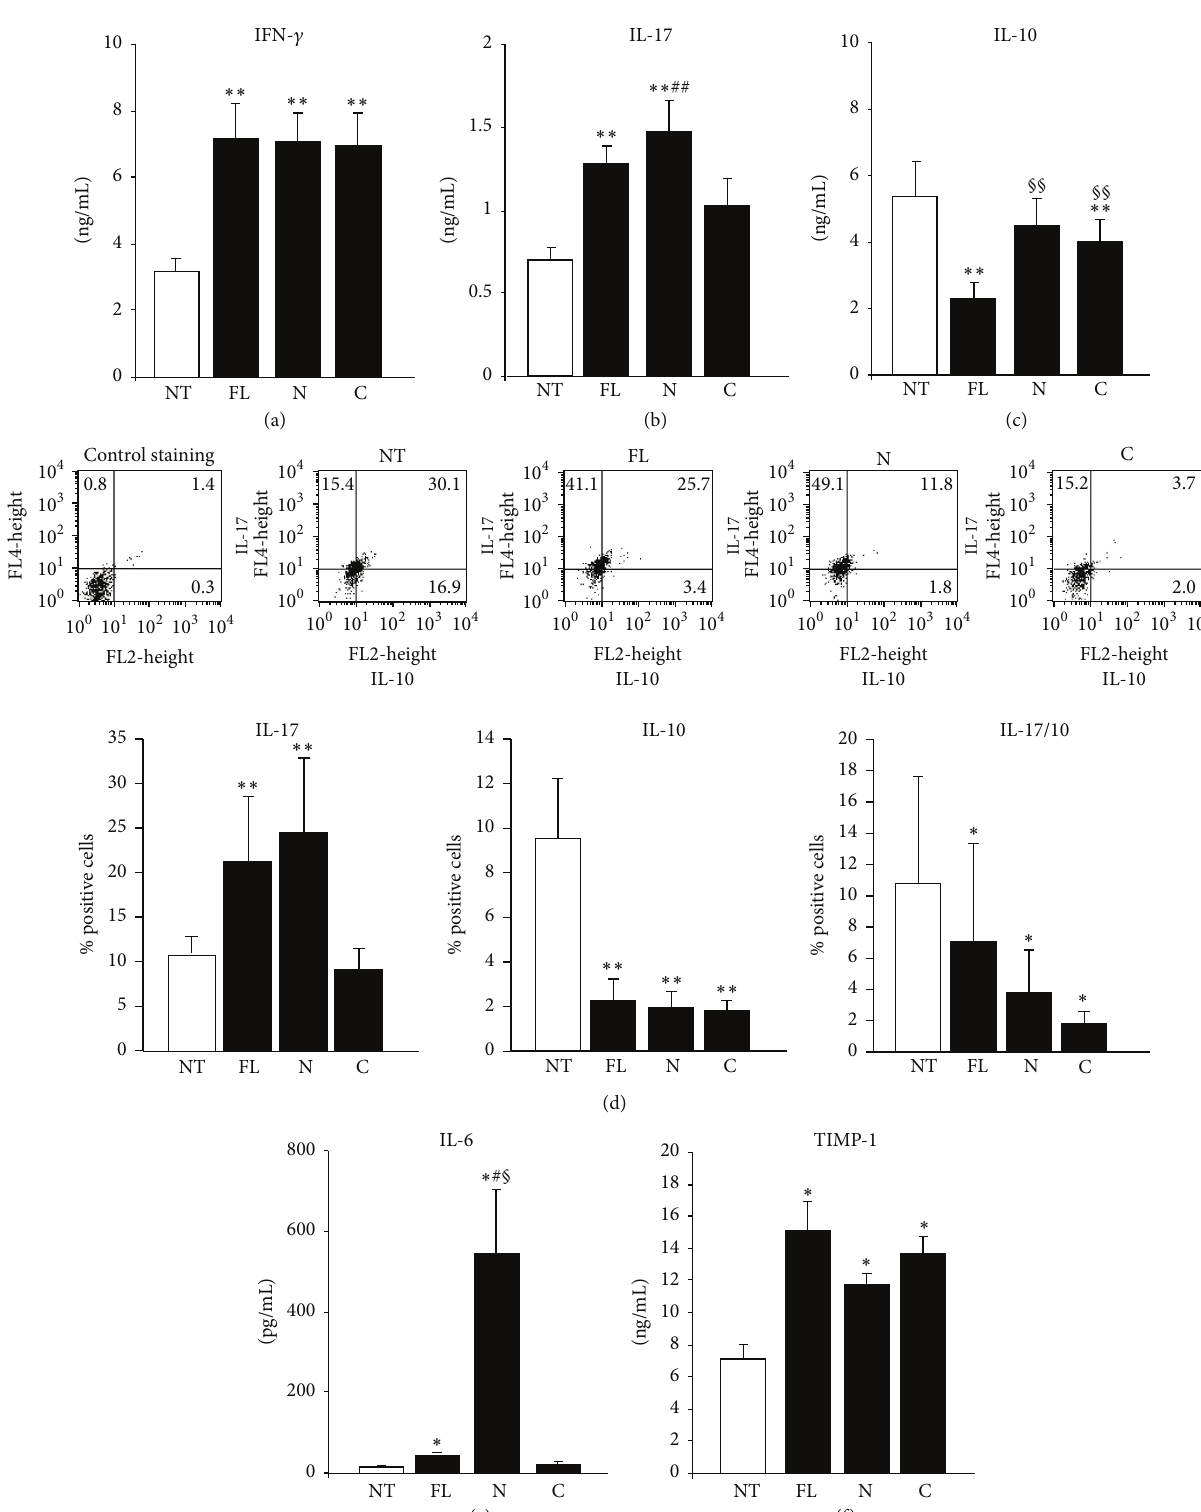
Figure 2: Effect of OPN fragments on cytokine secretion. (a) IFN- 𝛾 , (b) IL-17A, and (c) IL-10 protein evaluated in the culture supernatants from CD4 + T cells by ELISA or (d) by intracellular staining with anti-IL-17A and anti-IL-10 after 5 days of treatment with OPN variants. (e) IL-6 and (f) TIMP-1 protein secreted by monocytes after 2 days of treatment with OPN variants. Data are expressed as the mean ± SE from 6 independent experiments ( ∗ 𝑝 < 0.05 ; ∗∗ 𝑝 ≤ 0.01 versus the control; § 𝑝 < 0.05 ; §§ 𝑝 ≤ 0.01 versus OPN-FL; # 𝑝 < 0.05 ; ## 𝑝 ≤ 0.01 versus OPN-C; Wilcoxon’s signed rank